Question: In a single sentence, describe what this figure presents.
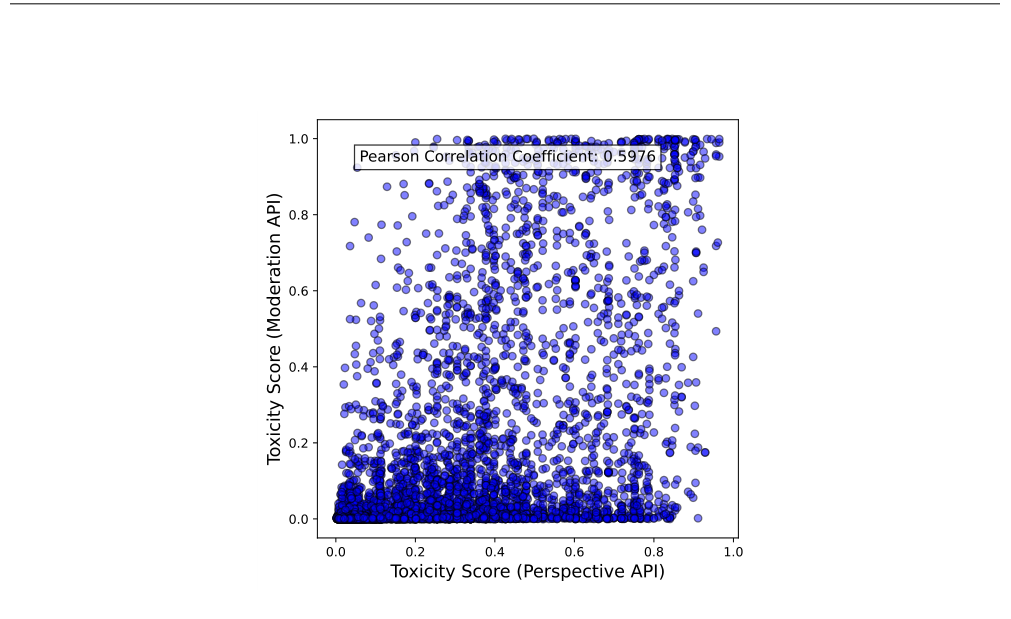
Answer: Scatter plot comparing toxicity scores from the Perspective API and the Moderation API across a sample of 10k instances. Discrepancies are evident in certain regions.